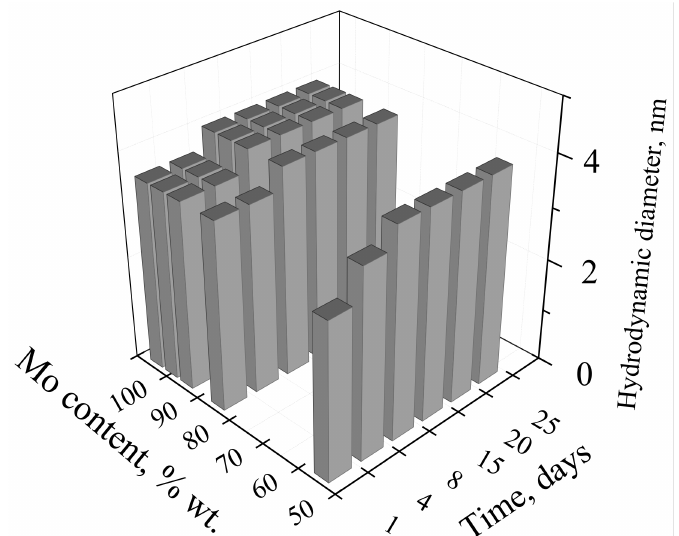
Figure 2. The dependence of the hydrodynamic diameter of particles on the composition of molybdenum–tungsten blue particles (molar ratio (R)/(Me) = 1.0; (H)/(Me) =